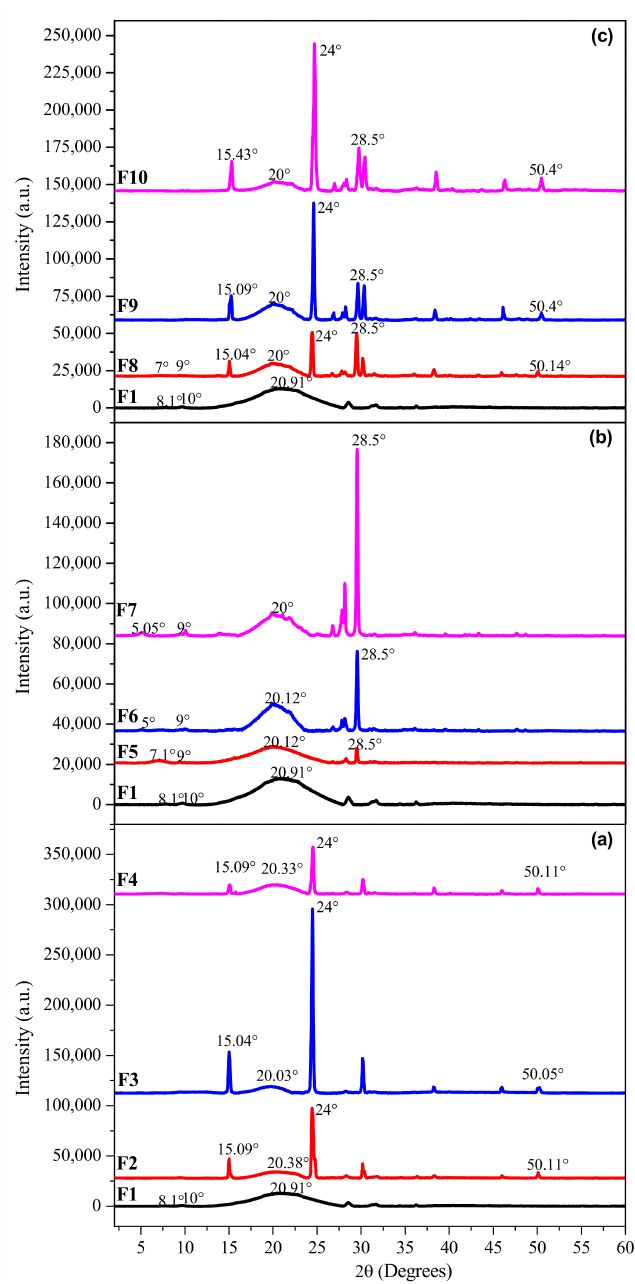
Figure 5. X-ray diffraction patterns of the reinforced gelatin biofilms. ( a ) Diffractograms of biofilms F1 to F4, ( b ) Diffractograms of biofilms F1, F5 to F7 and ( c ) Diffractograms of biofilms F1, F8 to